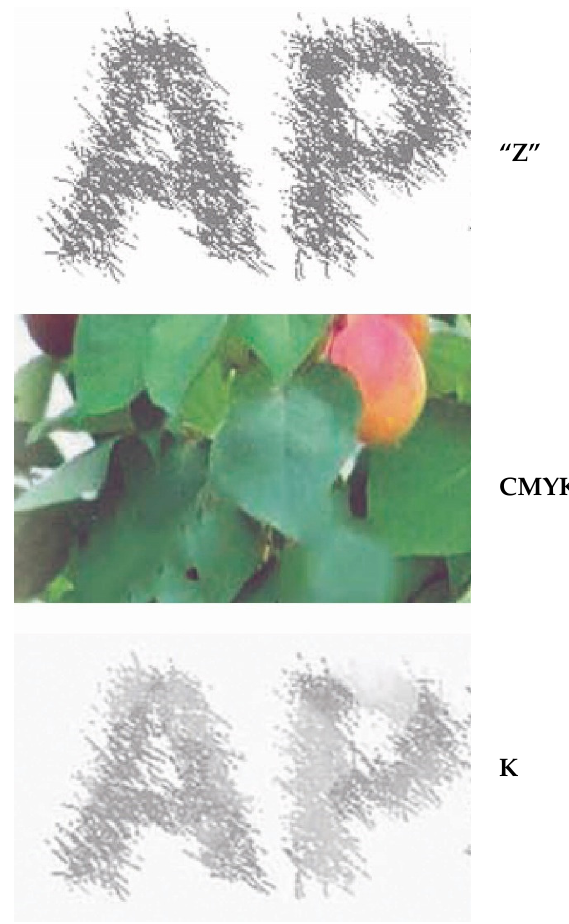
Figure 3. Hidden information in the color image.